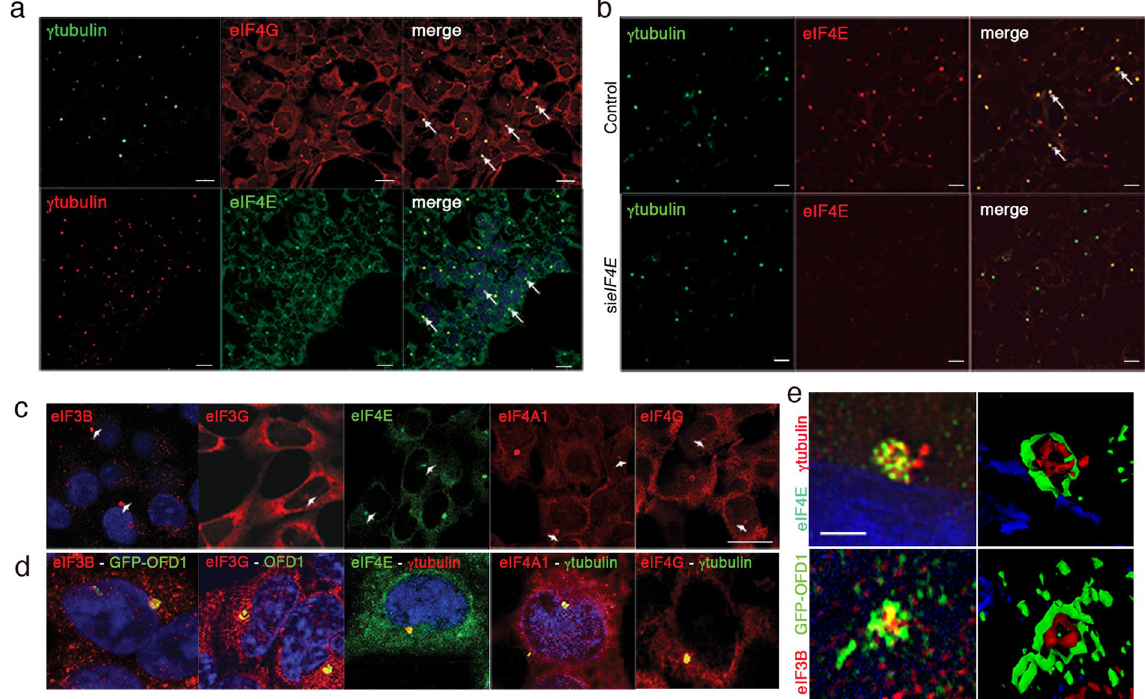
Figure 6. Translation initiation factors localize at the centrosome in HEK293 cells. ( a ) Immunofluorescence experiments demonstrate that eIF4G and eIF4E colocalize with γ , a centrosomal marker (arrows). ( b ) Silencing of eIF4E results in downregulation of the signal, confirming the specificity of the immunostaining of the eIF4E antibody. ( c ) Single channel IF are presented for each protein analysed, arrowheads indicate the staining that suggest the centrosomal localization. ( d ) Magnification of IF experiments showing colocalization of eIF3B, eIF3G, eIF4E, eIF4A1, eIF4G with centrosomal markers (OFD1 or γ tubulin). ( e ) Analysis of centrosomal localization of eIF4E and eIF3B by Superresolution microscopy. IF (left panels) and 3D reconstruction (right panels) are provided. Bar = 10 μ m. For Superresolution images Bar = 2 μ m. For all panels n =